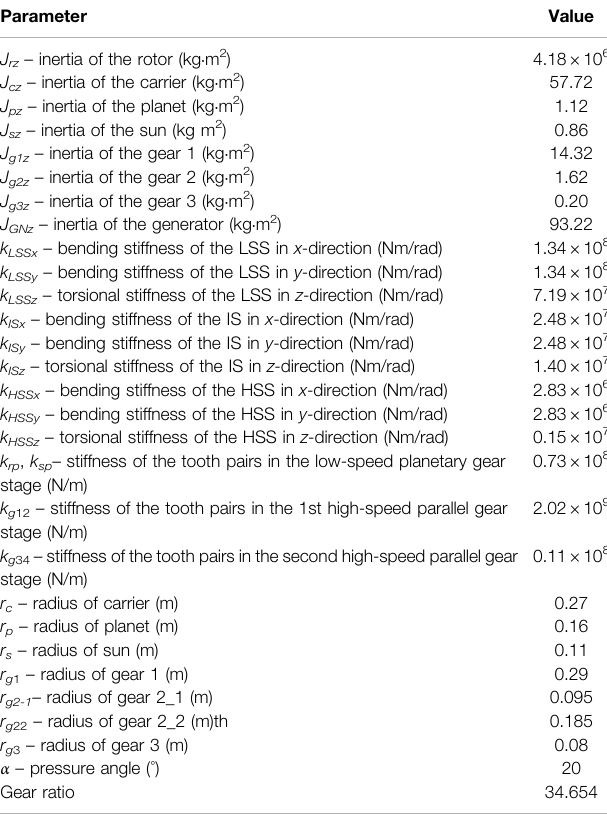
TABLE 2 | Main properties of the drivetrain con fi